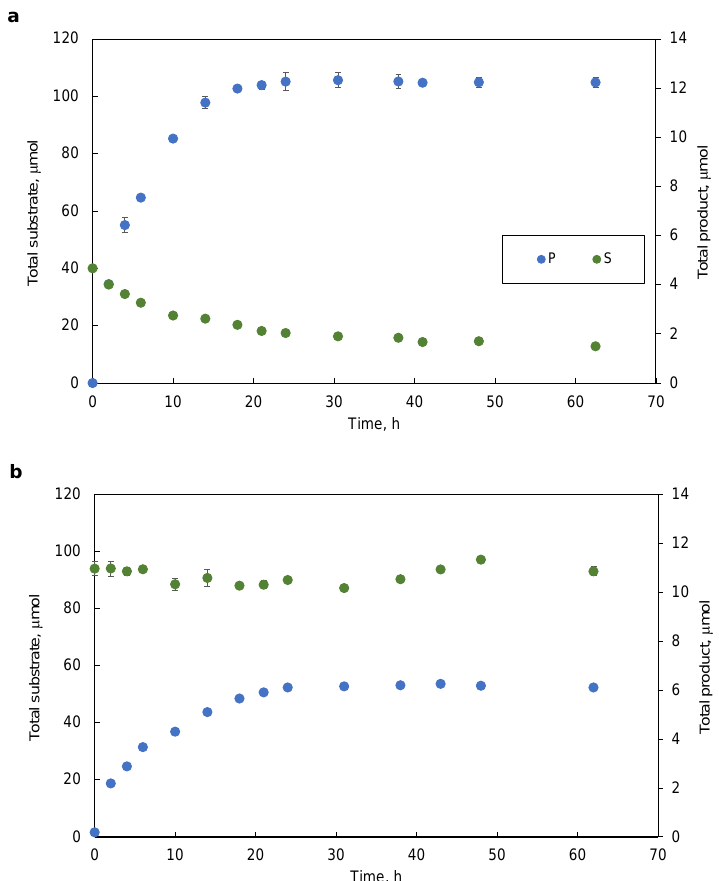
Figure 3. Quantities of 4′-(trifluoromethyl)acetophenone (S) consumed and of 4-trifluoromethylphenyl) ethylamine (product; P) produced during the bioconversion catalyzed by TR 8 in one-phase ( a ), and two-phase ( b ) systems.